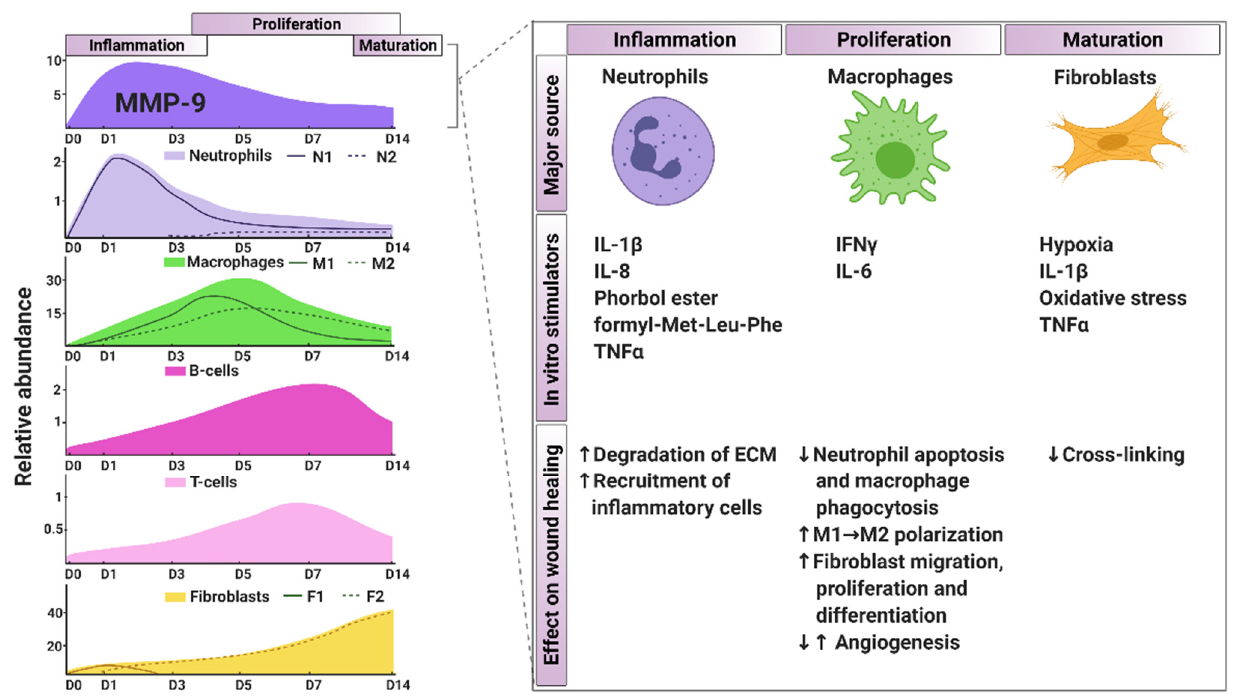
Figure 1. Temporal profile of MMP-9, leukocytes, and fibroblasts during myocardial infarction wound healing. The left side shows the temporal profile of MMP-9 and the relative abundance of neutrophils, macrophages, B-cells, T-cells, and fibroblasts during inflammation, proliferation and maturation phase. The graphs are based on the current literature [77–84]. The right side shows the cellular source of MMP-9, as well as in vitro stimulators of MMP-9 release and the effect of MMP-9 on different myocardial infarction wound healing processes. IL-1 β : Interleukin 1 beta, IL-8: Interleukin 8, MMP-9: Matrix metalloproteinase-9, TNF α : Tumor necrosis alpha, N1: Pro-inflammatory neutrophils, N2: Anti-inflammatory/reparative neutrophils, M1: Pro-inflammatory macrophages, M2: Anti-inflammatory/reparative macrophages, F1: Pro-inflammatory fibroblasts, F2: Anti-inflammatory/reparative fibroblasts. Created with BioRender.com (accessed on 23 March 2021) [85] .